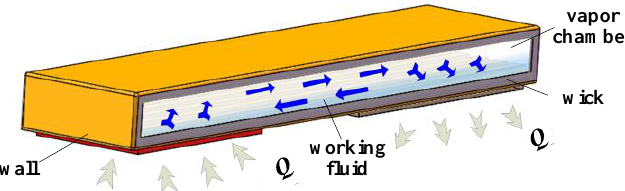
Figure 1. Structure of mini flat heat pipe.